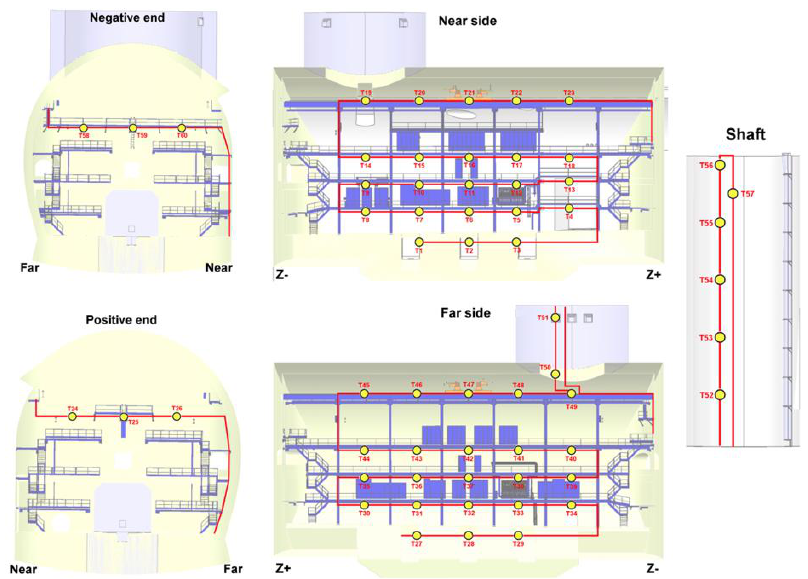
Figure 25. Layout of the CMS Experimental Underground Cavern (UXC) FBG-based temperature monitoring system. The positions of the FBG-based temperature sensors are denoted with “T” (from monitoring system. The positions of the FBG- based temperature sensors are denoted with “T” (from T1 to T1 to T57).